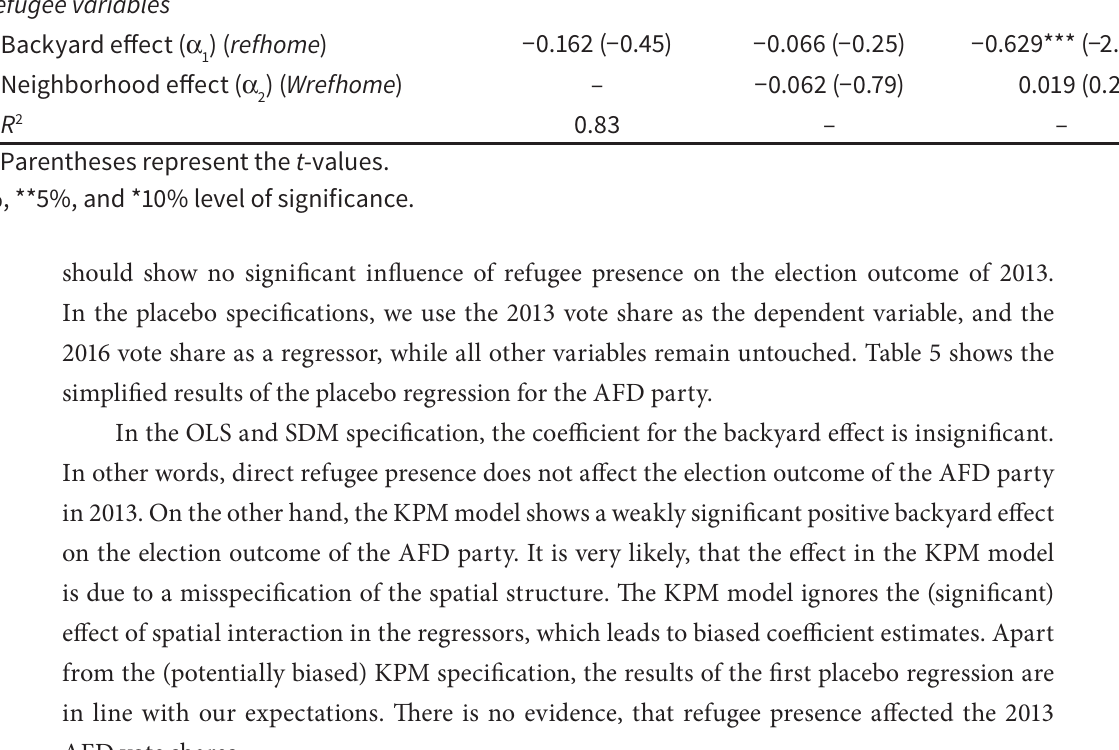
Placebo regression for the CDU vote shares in the year 2013 in percentage points Dependent variable: CDU ’13 vote